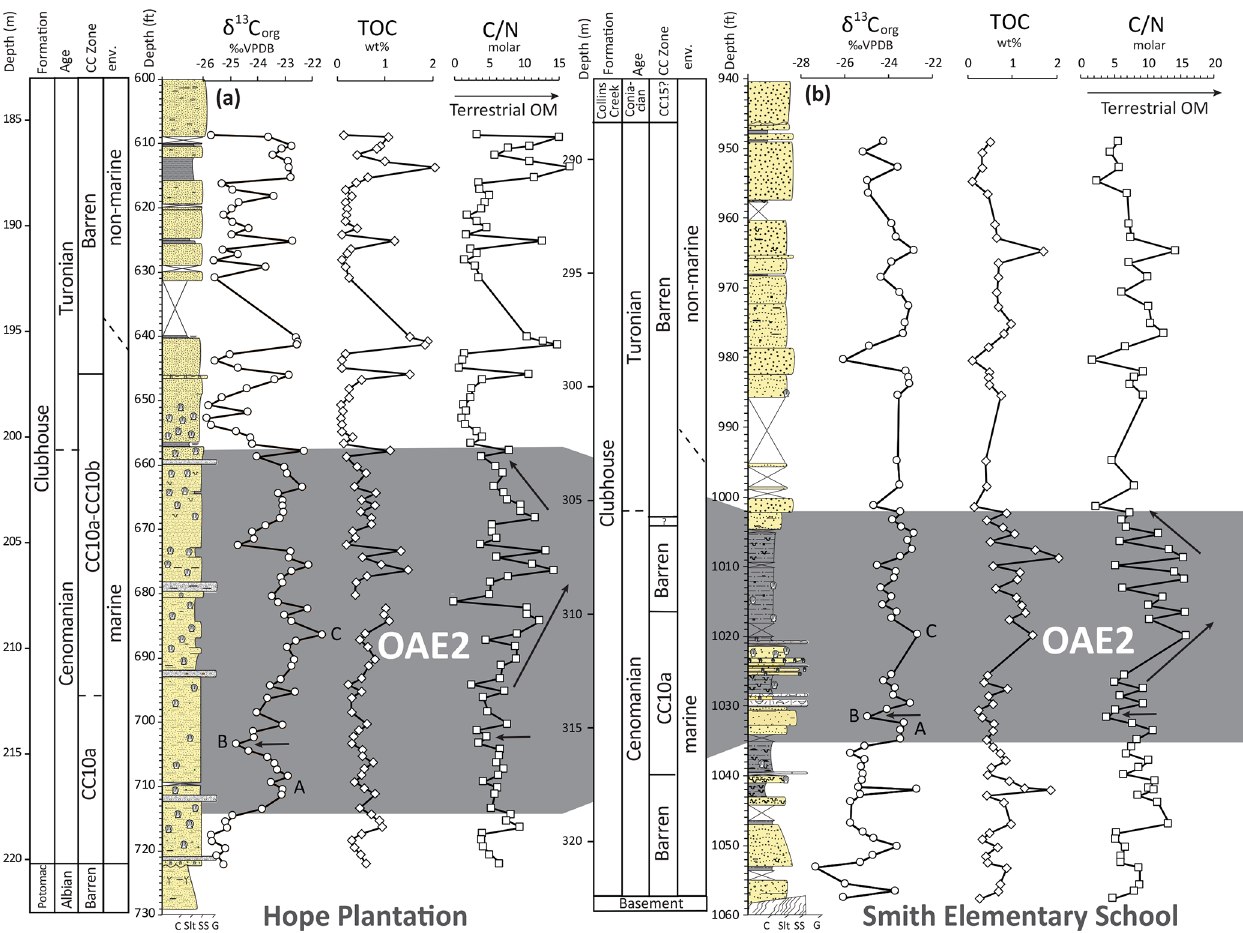
Figure 6. Geochemical data from the Hope Plantation (a) and Smith Elementary School (b) cores plotted against stratigraphic columns for each. The gray shaded area represents the OAE2 interval in each core. A–B–C labels on the carbon isotope ( δ 13 C) curve correspond to named points of the OAE carbon isotope excursion (see Fig. 7). TOC: total organic carbon; C / N: carbon / nitrogen ratio. Arrows indicate a brief reduction in the C / N ratio coincident with the Plenus isotope excursion (“B” on the δ 13 C plot) and a broad increase in values during the main part of the δ 13 C excursion. Note the slight change in depth scale between the two cores, as the studied interval at Smith Elementary is 10ft (3.1m) thicker than at Hope